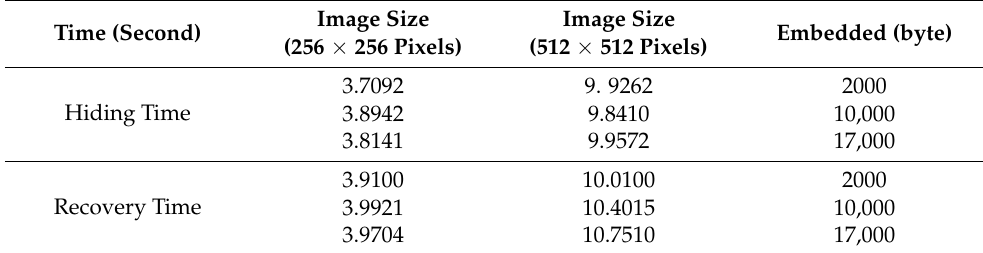
Table 6. A comparison of concealment and recovery times for different colour image